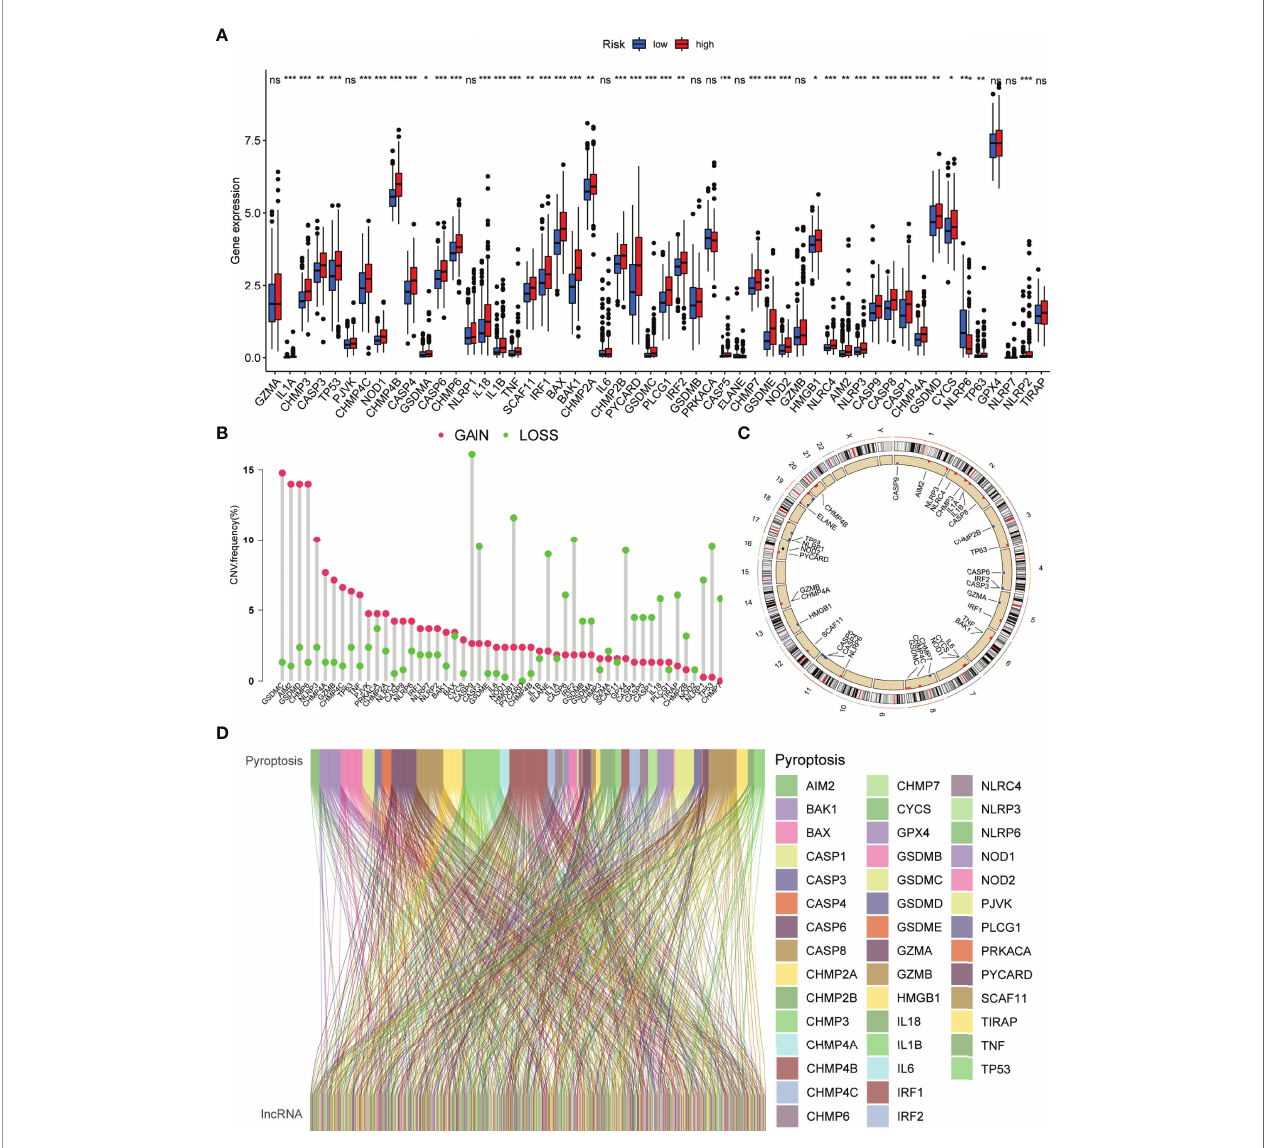
FIGURE 2 | Genetic and expression variation of the PRG gene in HCC. (A) Comparative analysis of normal and HCC tissues based on 52 PRGs. (B) The CNV frequency of 52 PRGs in the HCC cohort. (C) Assessment of the 23 chromosomes to identify the location of CNVs among 52 PRGs in the HCC cohort. (D) Sankey diagram depicting the relationships between 52 PRGs and PR-lncRNAs (ns, no signi fi cance; *P < 0.05; **P < 0.01; ***P <